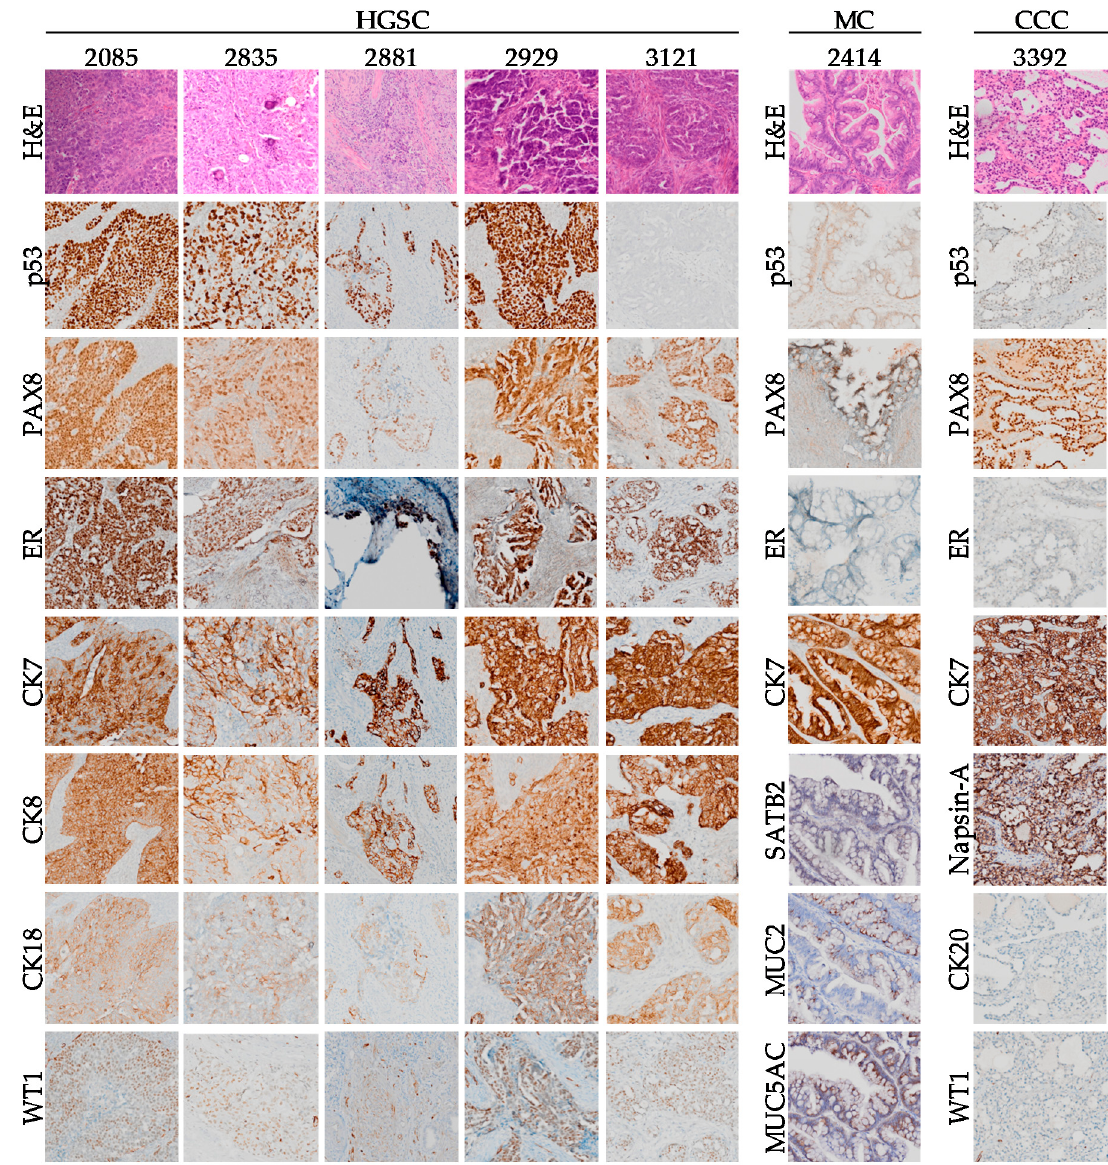
Figure 3. Immunohistochemistry staining for ovarian cancer markers. Shown are immunohistochemistry (IHC) staining of the tumor of origin from which each cell line was derived, separated by subtype. Each tumor was tested for relevant biomarkers for its respective subtype.